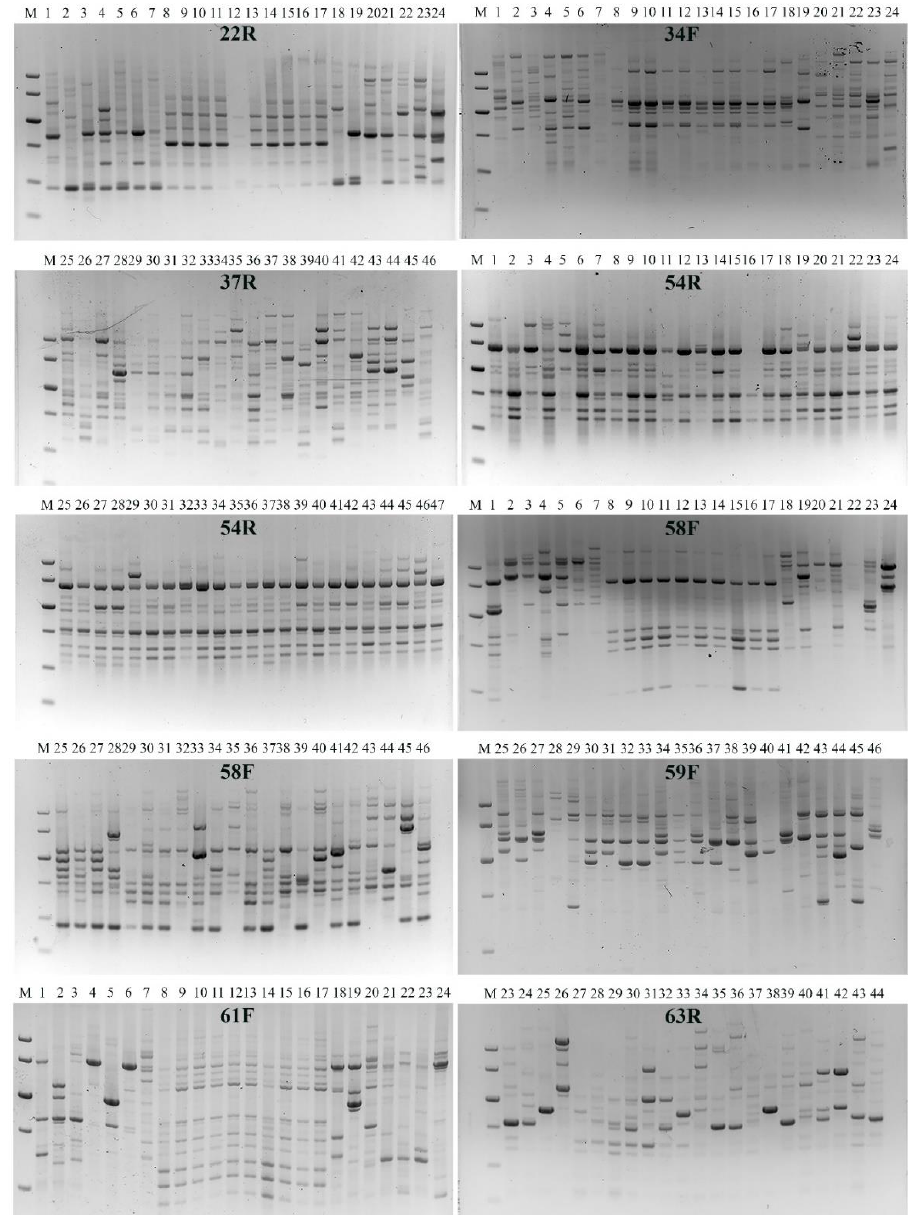
Figure 2. Inter-retrotransposon amplified polymorphism (IRAP) gel fingerprints. Negative agarose gels illustrate the results achieved in di ff erent Asian bamboo accessions for di ff erent IRAP markers. The bold black letters on top of the gel are the names of the IRAP marker. M above the gel on the left side represents 1 kb DNA Ladder mix (Takara). Numbers 1–47 represent di ff erent Asian bamboo species as defined in Table